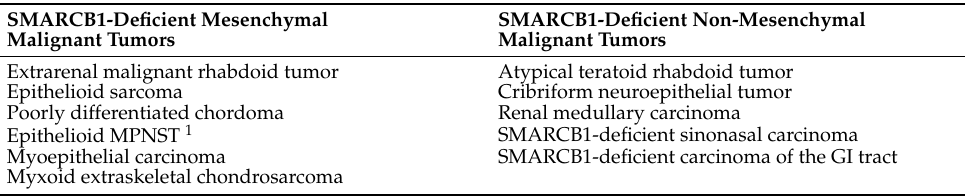
Table 1. SMARCB1-deficient malignant